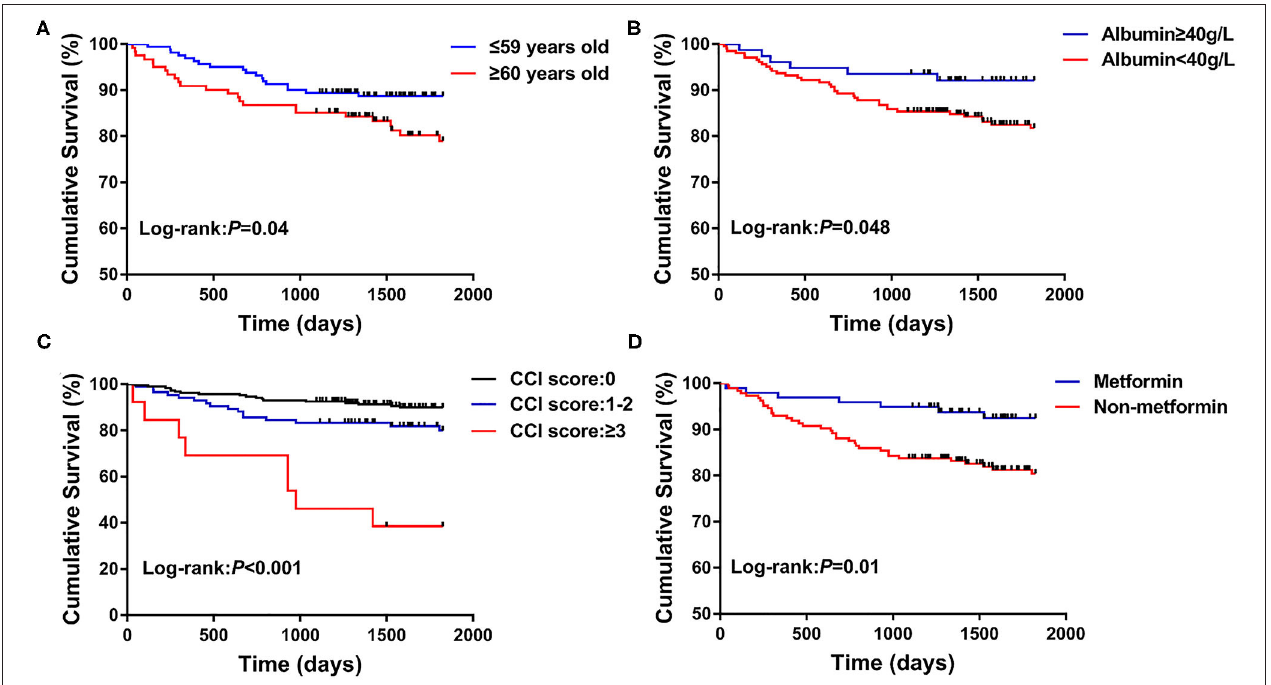
FIGURE 2 | Kaplan–Meier curves of the long-term survival according to age category (A) , albumin category (B) , CCI score (C) , and the use of metformin (D)